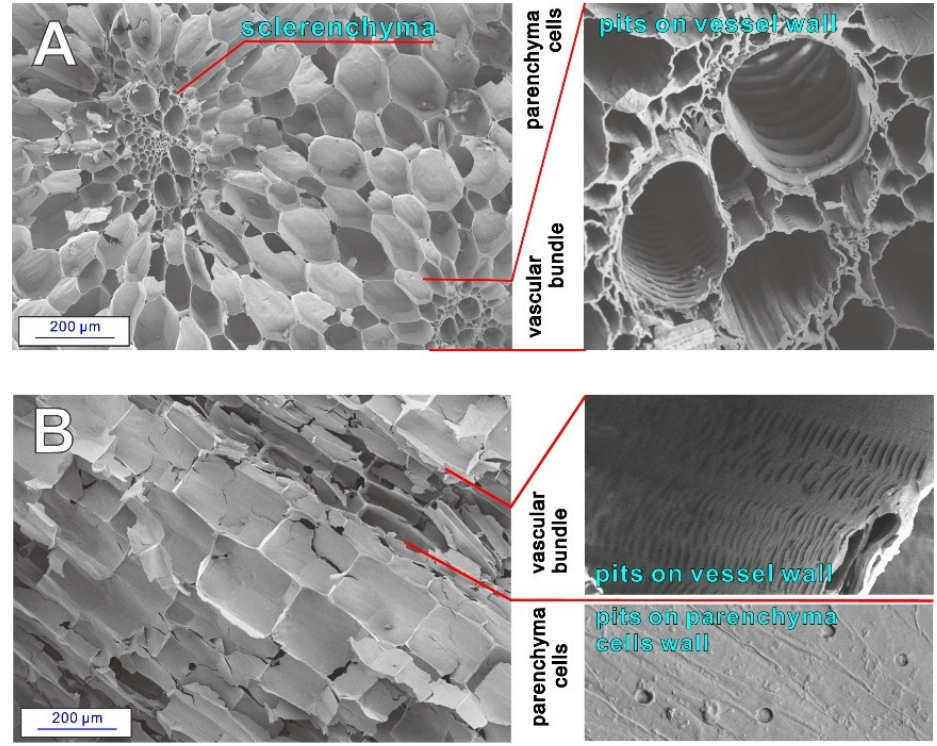
Figure 3. SEM micrographs of the SC–HA/C composite prepared with sugarcane top biotemplates. ( A ) SC–HA/C composite in transverse SEM image; ( B ) SC–HA/C composite in longitudinal SEM image.